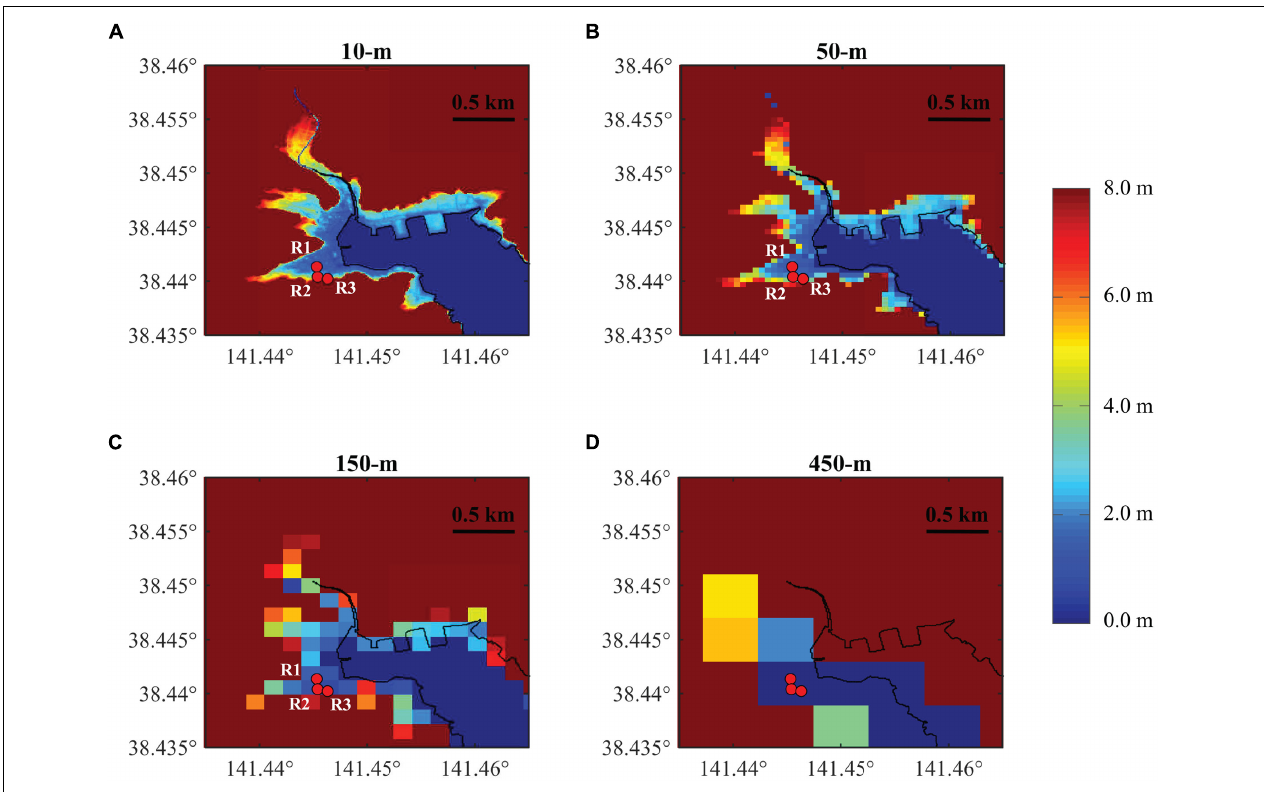
FIGURE 4 | Elevation maps for region RR1 in Onagawa of different resolutions: (A) 10-m, (B) 50-m, (C) 150-m, and (D) 450-m.